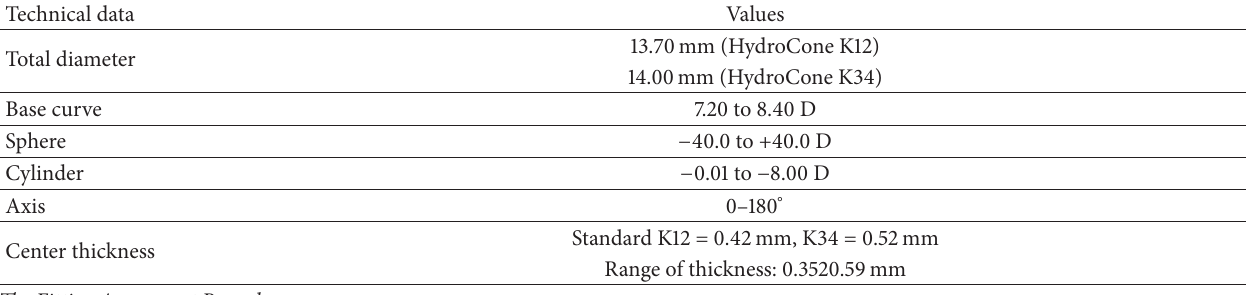
Table 1: The fitting set parameters and the fitting assessment procedure of Toris